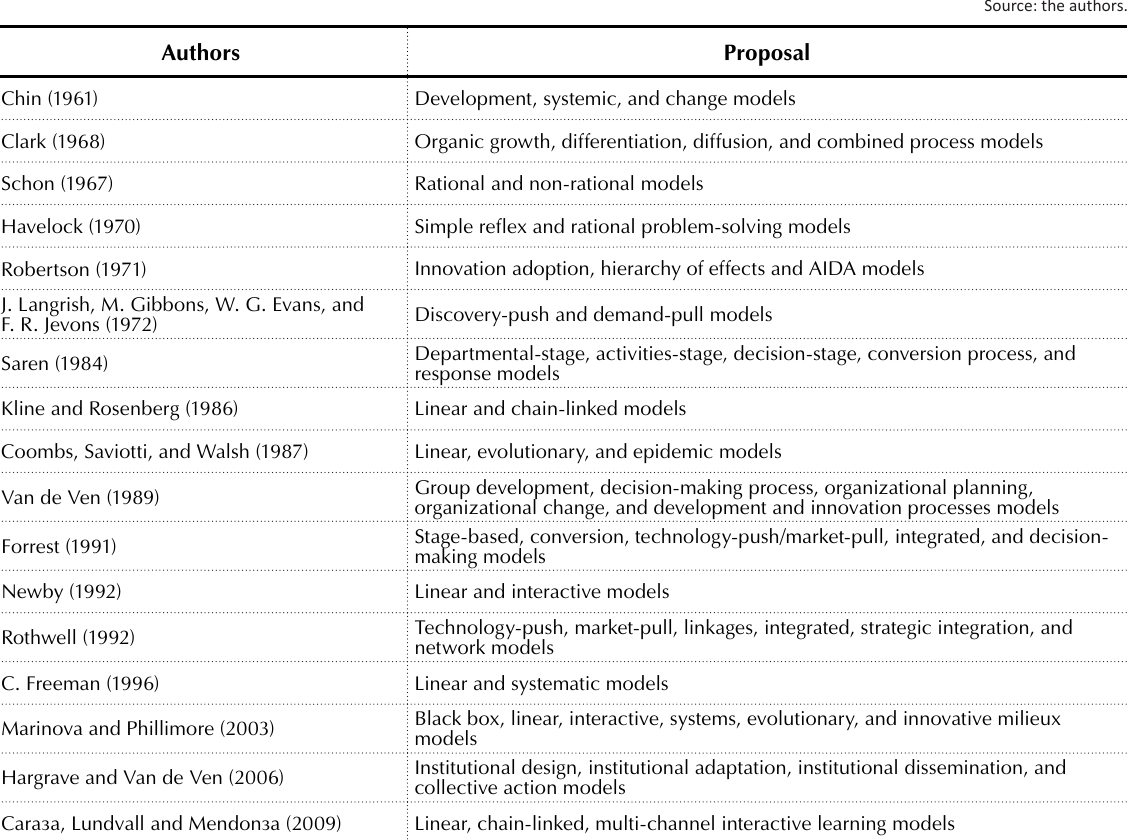
Table 1. Models of innovation management